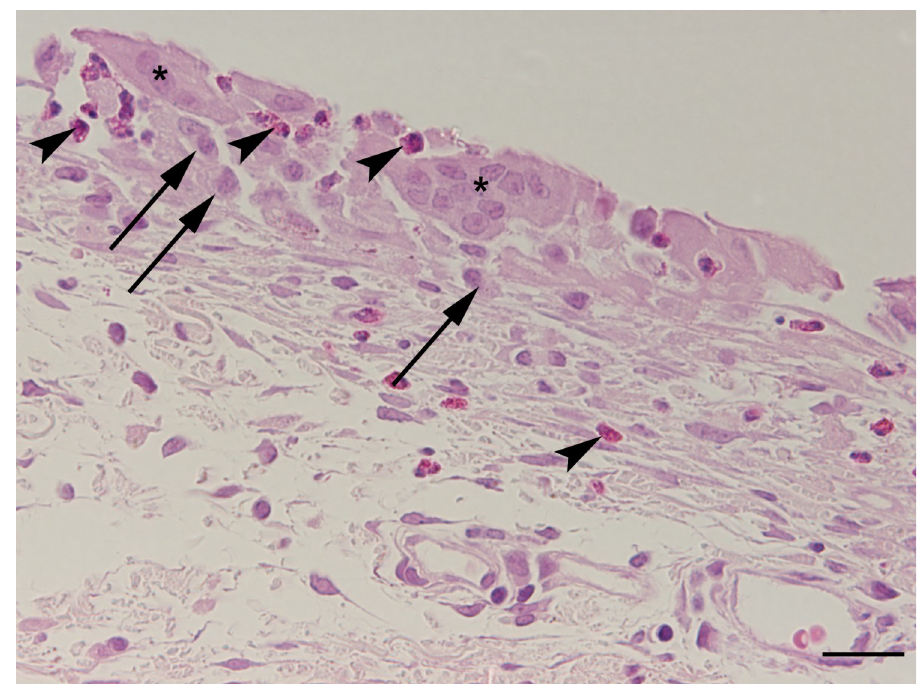
Fig 10. Higher magnification of the marked area in Fig 9. The cavity is surrounded by macrophages (arrows), multinucleated giant cells (asterisks) and heterophilic granulocytes (arrowheads) indicating granulomatous foreign body reaction; haematoxylin-eosin staining; bar 50 μ m.